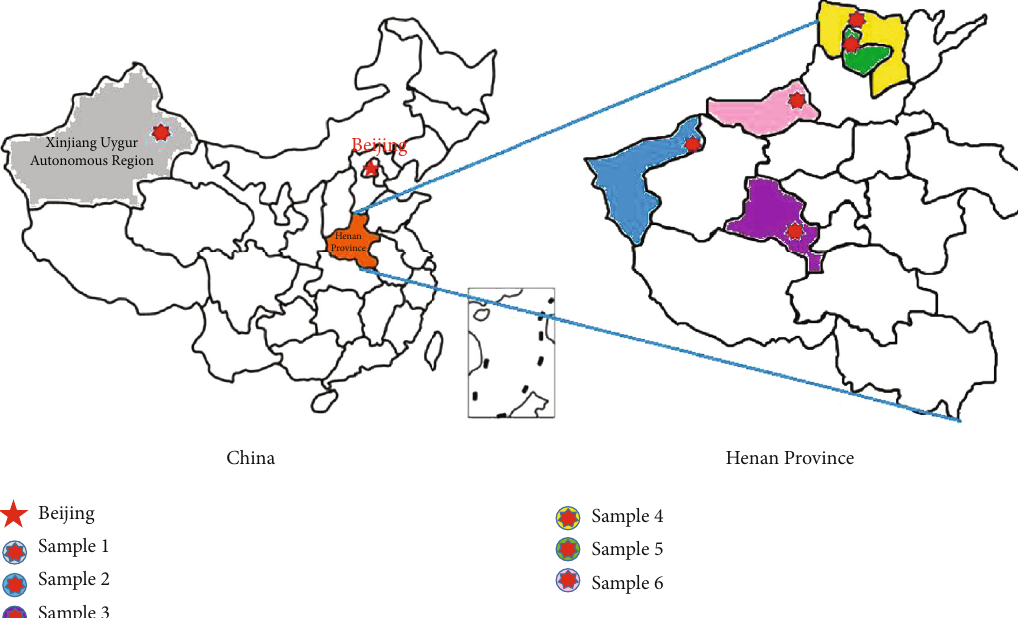
Figure 1: Sampling locations of experimental coal